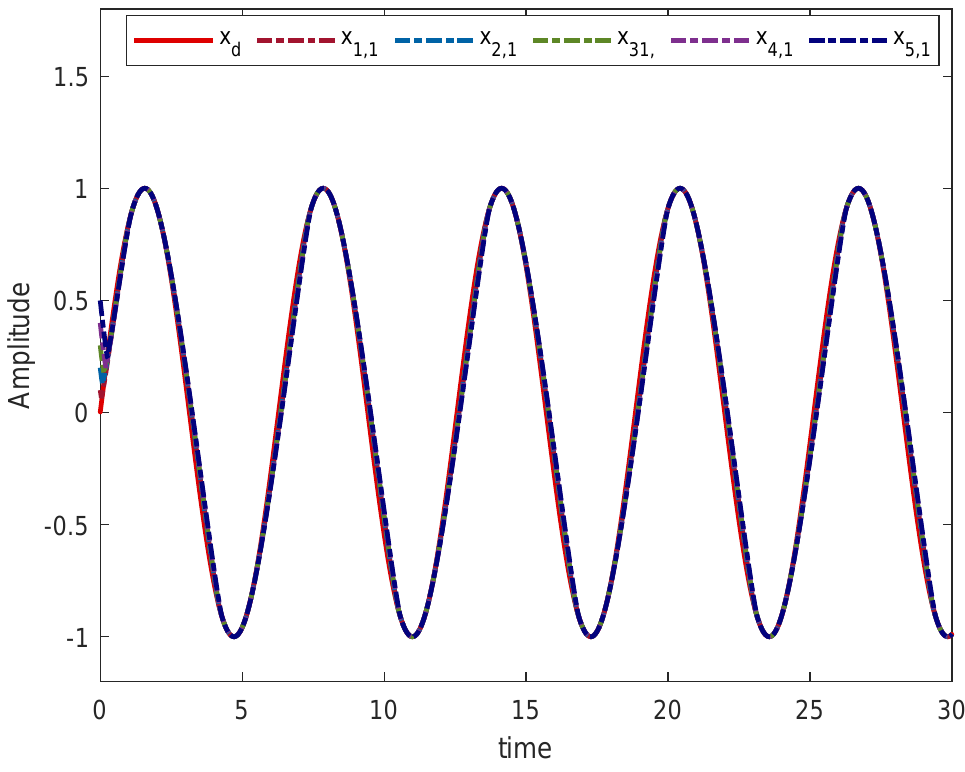
Figure 17. The trajectories of x d and x i ,1 ( i = 1, · · · ,5 ) based on the finite-time distributed algorithm.